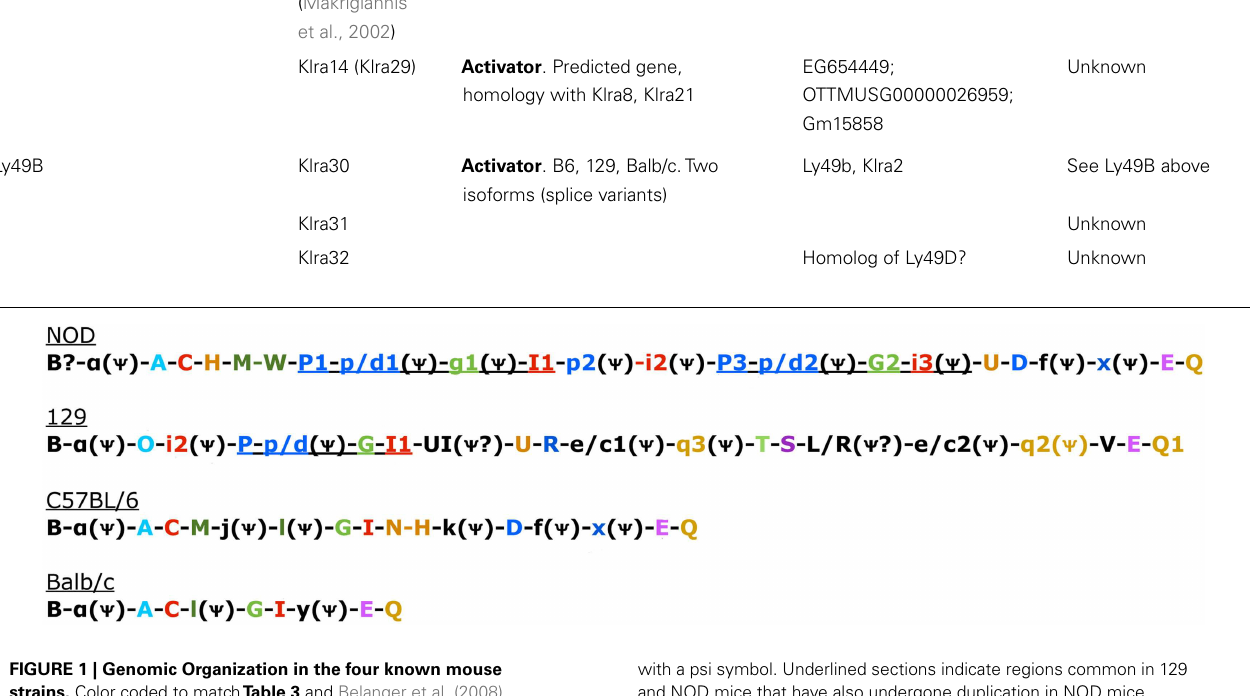
with a psi symbol. Underlined sections indicate regions common in 129 and NOD mice that have also undergone duplication in NOD mice (Belanger et al.,